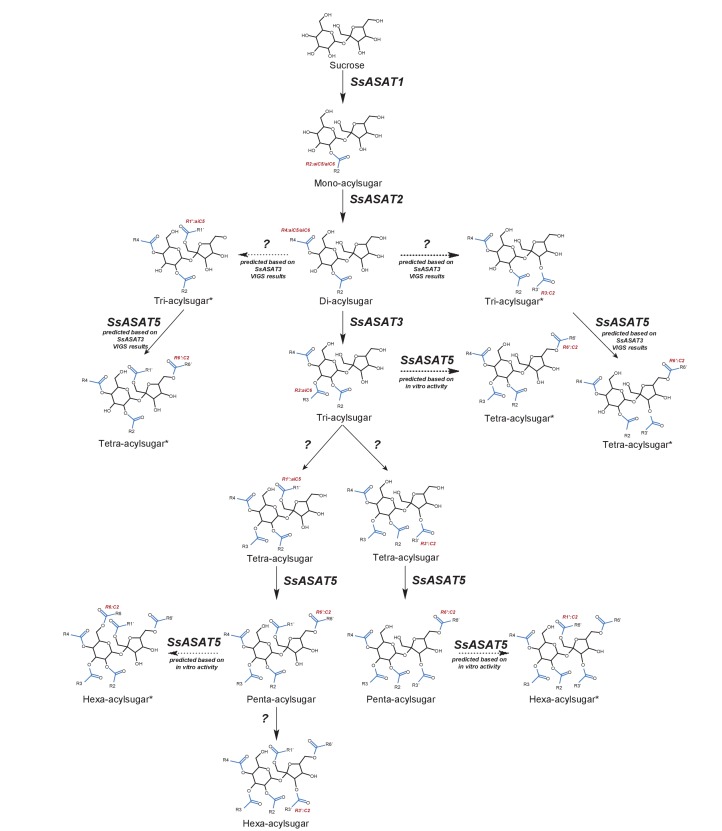
Model for the Salpiglossis acylsugar biosynthetic pathway.The question marks indicate unidentified enzymes. The blue colored acyl chains are positioned on the sucrose molecule based on results of positive mode fragmentation characteristics, co-elution assays, and comparisons with purified acylsugars. Main activities are shown in solid arrows and potential alternate activities - where acylation positions and enzymatic activities are hypothesized based on in vitro and in vivo findings - are shown in dashed arrows. An asterisk (*) next to the acylsugar names indicates no NMR structure is available for the acylsugar in Salpiglossis or Petunia, and the acyl chain positions are postulated based on their fragmentation patterns in positive and/or negative mode, and on hypothesized enzyme activities as described in the main text.